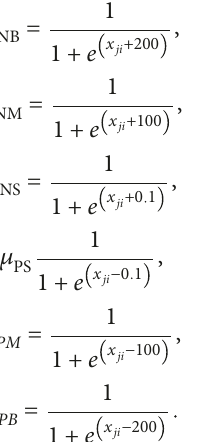
of Link 2 and ideal 12